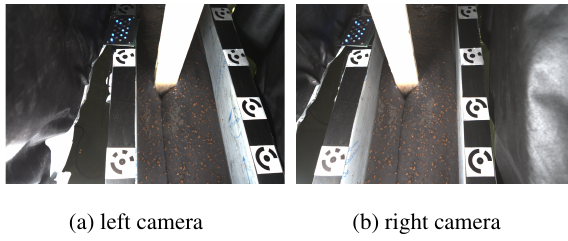
(a) left camera (b) right camera Figure 2. Pair of original images of sample 19, acquired at the same point of time. In the upper left part of each image, the blue LED panel can be